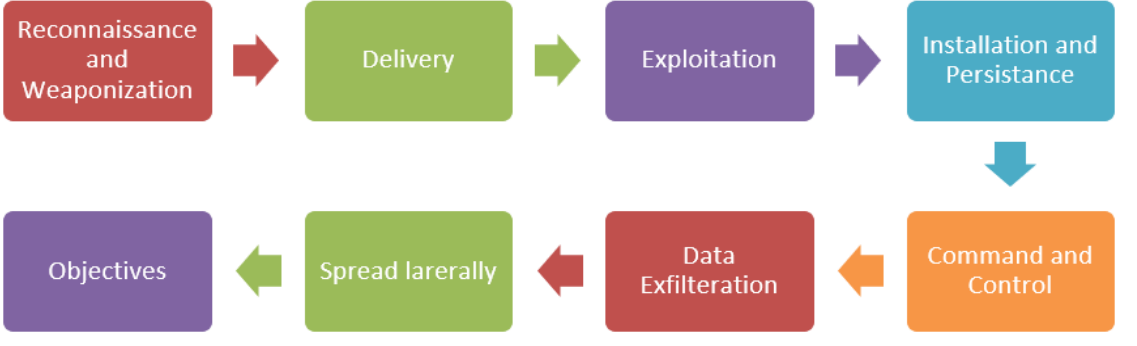
Figure 1. Malware exploitation stage.